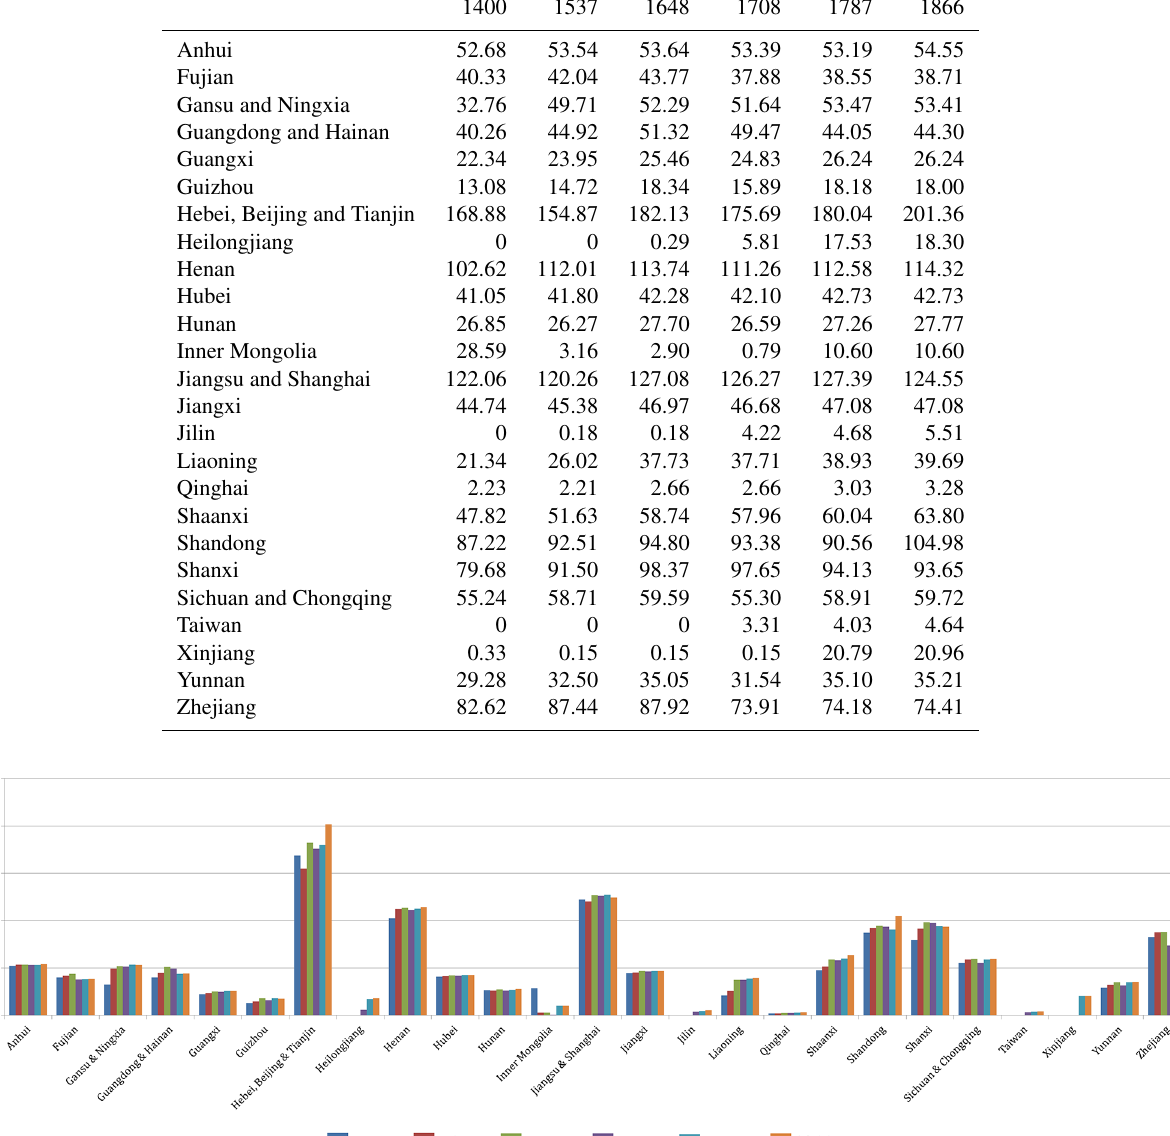
https://doi.org/10.6084/m9.figshare.14112968.v3 (Xue et